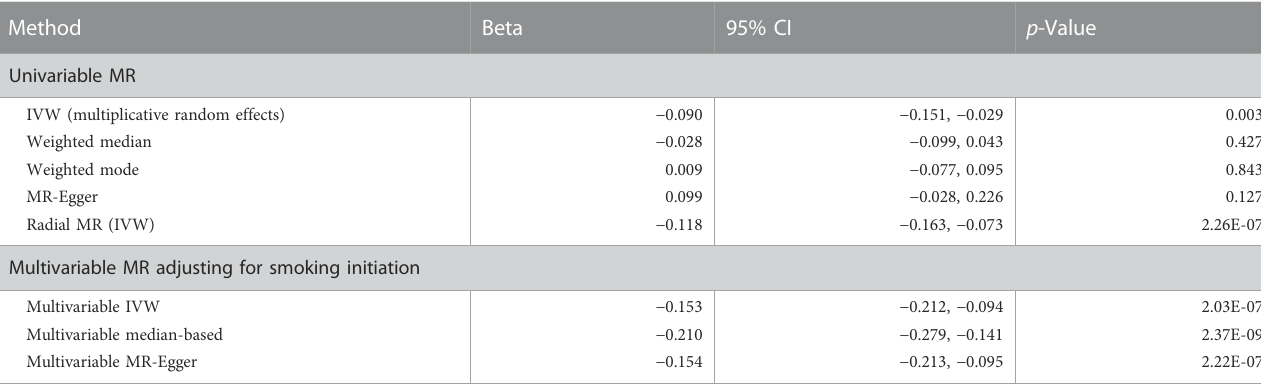
TABLE 2 MR results for the effect of alcohol consumption on the frailty